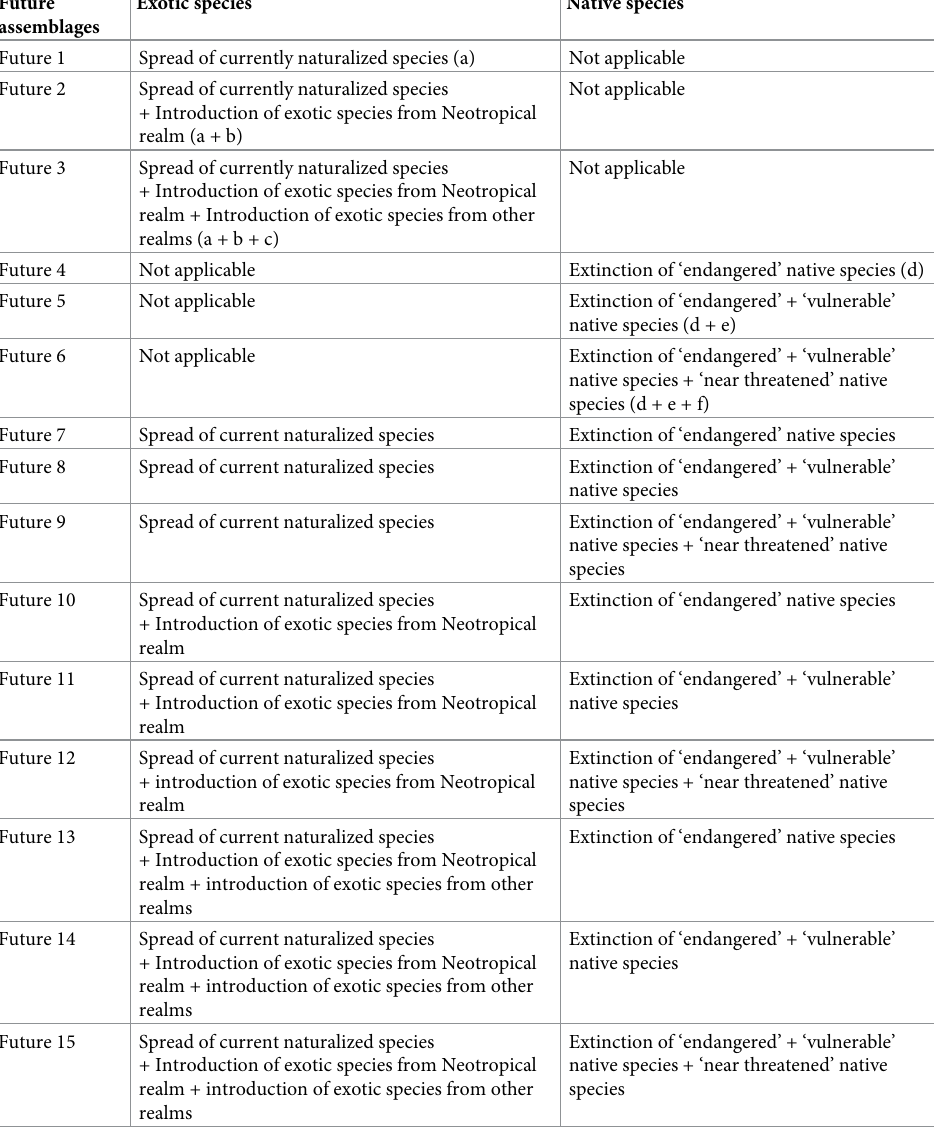
These scenarios were generated by using exotic species introductions (three levels: a, b, c) and native species extinctions/extirpations (three levels: d, e,